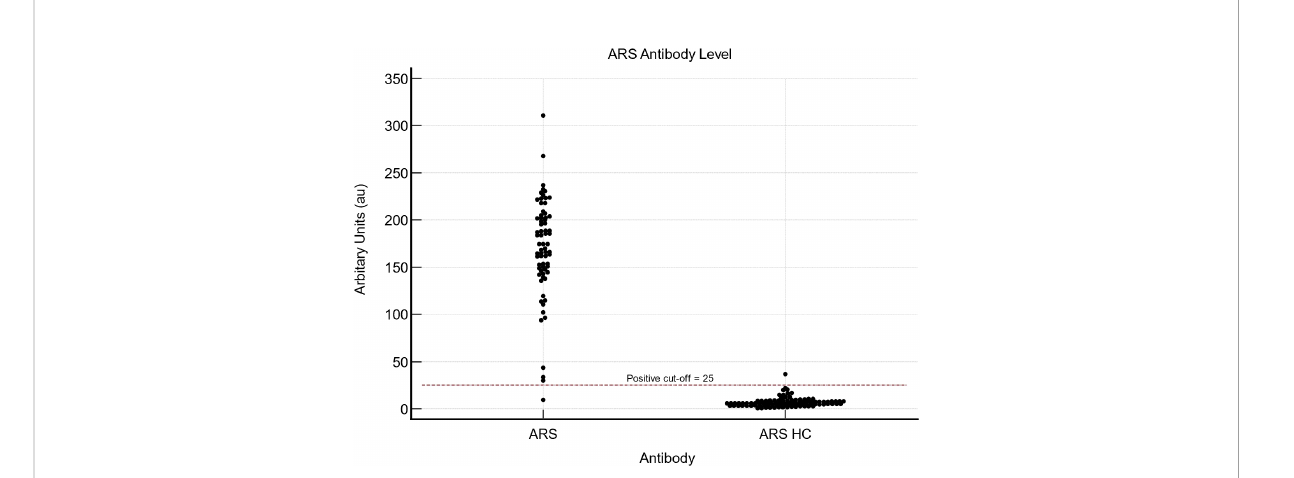
FIGURE 3 ARS ELISA values for 21 Jo1, 7 EJ, 2 Ks, 21 PL7, 19 PL12 and 117 healthy control